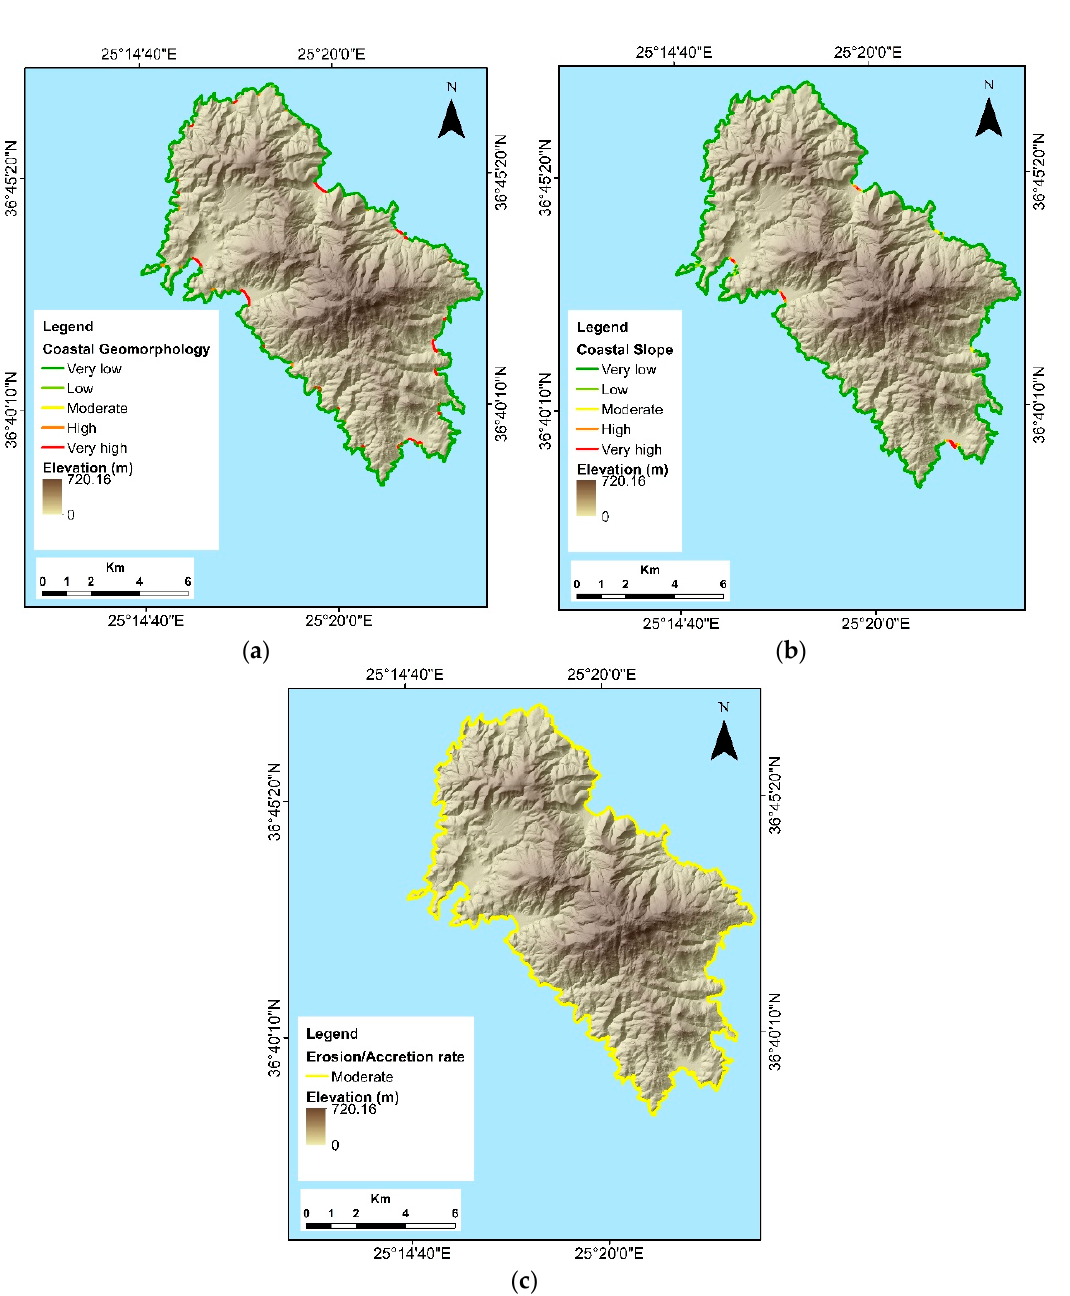
Figure 6. Map of vulnerability ranking of the geological variables: ( a ) Coastal Geomorphology; ( b ) Coastal Slope; ( c ) Shoreline displacement rate (Erosion/Accretion).